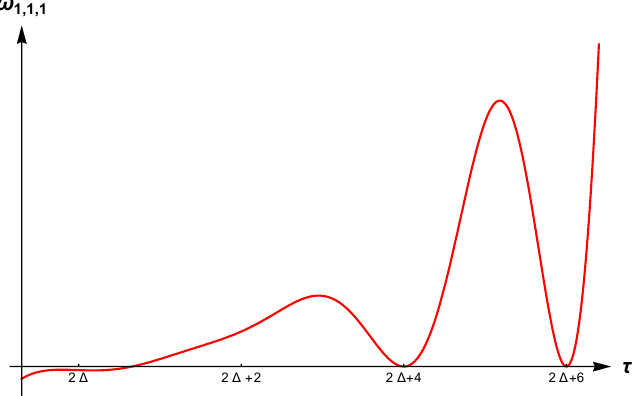
τ , (cid:96) ≡ (cid:80) ∞ ω τ , (cid:96) , m functional as a function of the twist τ m = 0 1,1,1 1,1,1 = 3 , γ , (cid:96) = 2 and d = 3. The plot 13 5 4